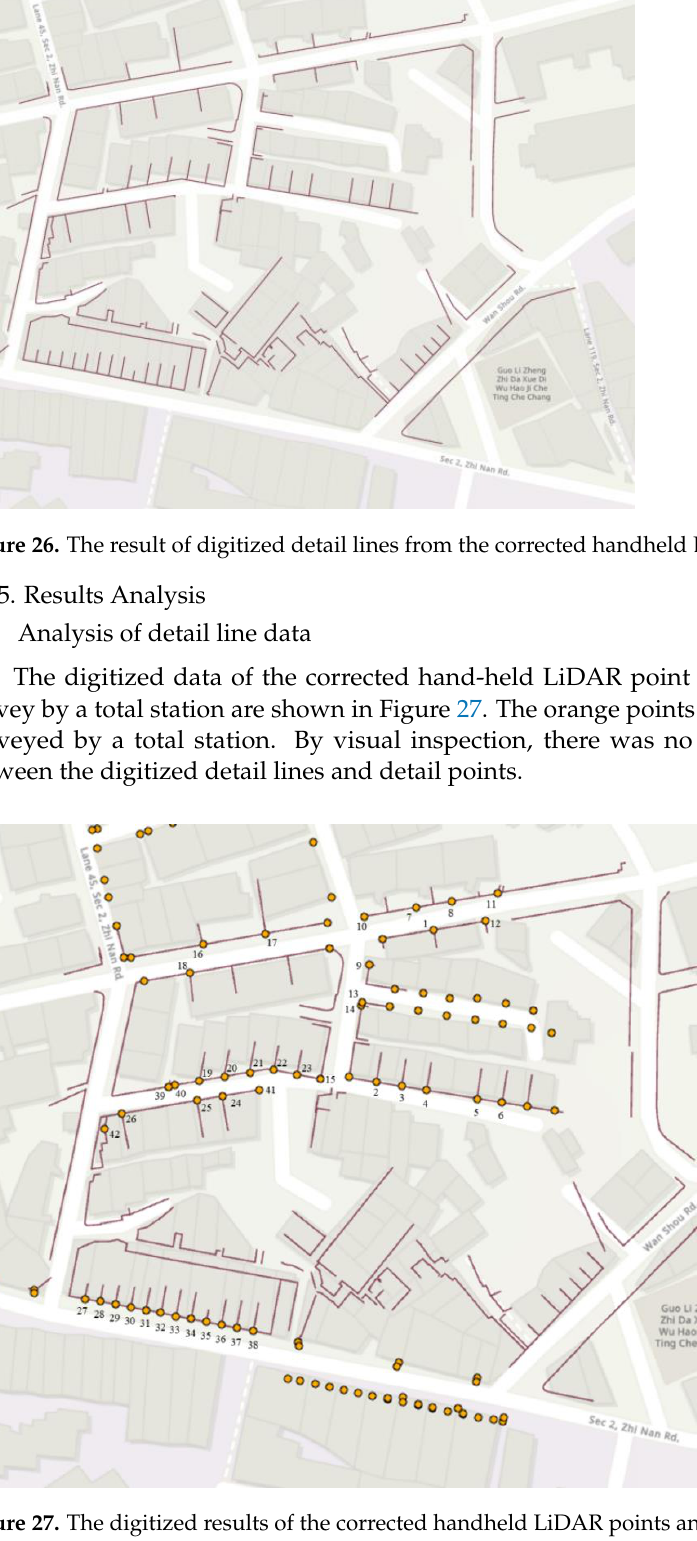
28 of 34 Figure 24. The image of a road boundary and the corresponding point cloud. ( a ) Image of a road boundary. ( b ) Point cloud of a road boundary. The digitization of a possible cadastral detail line on an existing road boundary is illustrated in Figure 25 where blue lines indicated the outermost boundary of the building top view. The outer boundary of the wall located on the road boundary was digitized, and then those line segments were connected as the possible cadastral detail line, as the line EF shown in Figure 25. Figure 25. The digitized process of the possible cadastral line close to the road boundary.